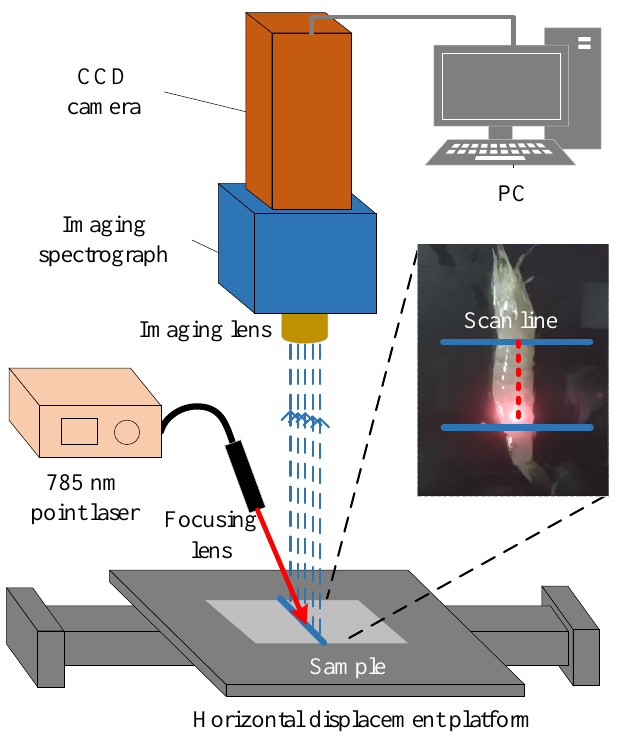
Figure 1. Line-scan Raman scattering image acquisition system.